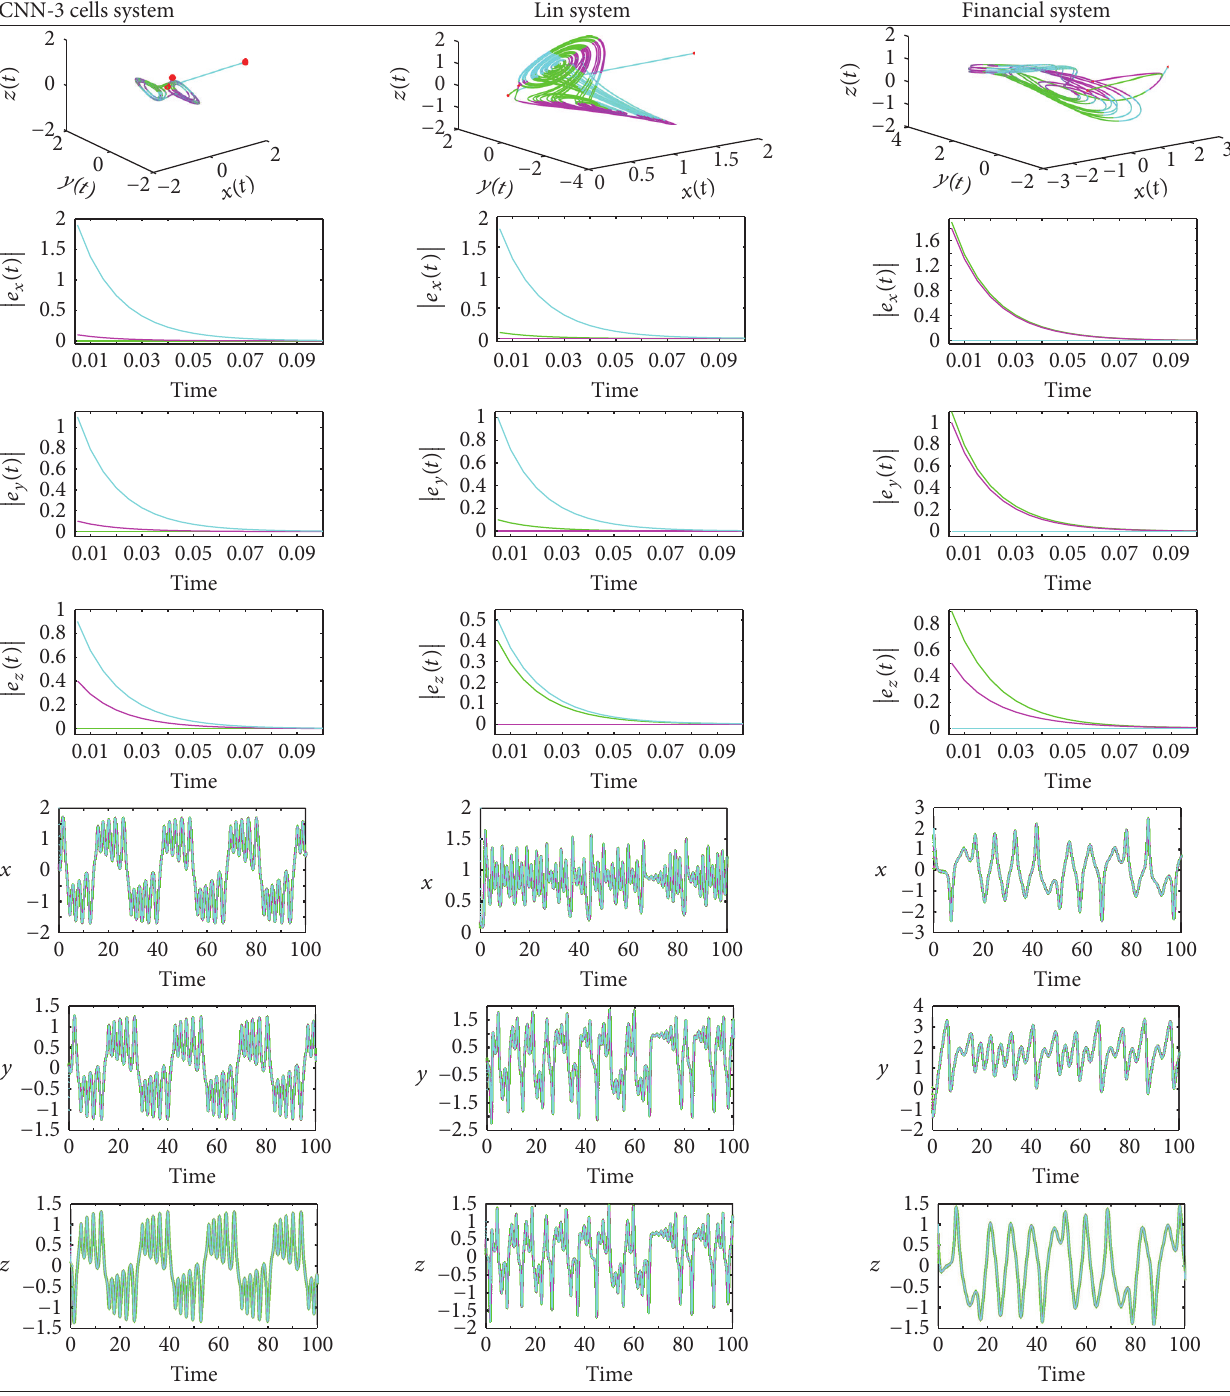
Table 2: Attractor diagrams and error functions in case of static synchronization with a single master. CNN-3 cells system Lin